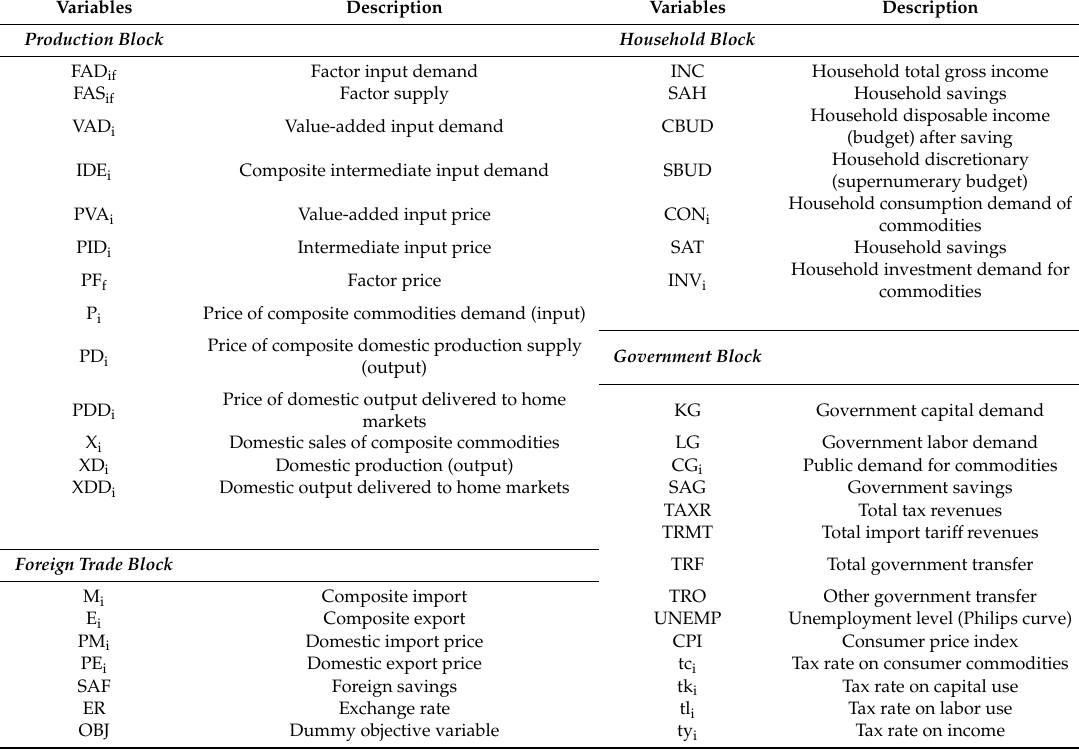
Table A1. Computable General Equilibrium (CGE) model